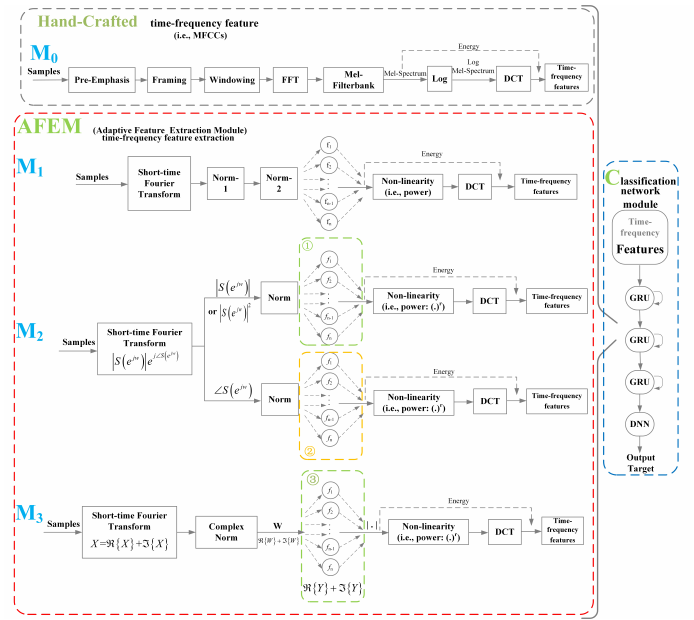
Figure 5. Neural network configurations: M 0 model (baseline model): hand-crafted time-frequency feature and classification network module; M 1 model: M 1 -AFEM and classification network module; M 2 model: M 2 -AFEM and classification network module; M 3 model: M 3 -AFEM and classification network